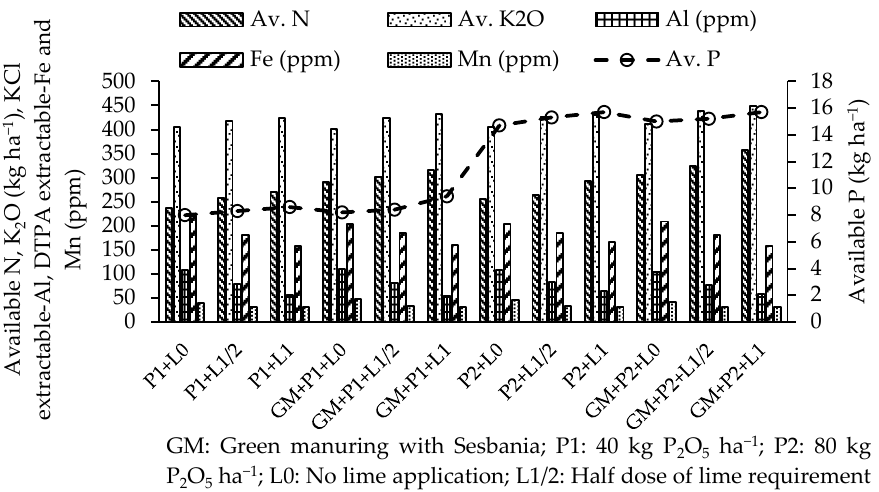
Figure 6. Effect of green manuring, liming, and P fertilizer application on soil-available nutrients of acid saline soils of the Ganges Delta. Adapted from [49].